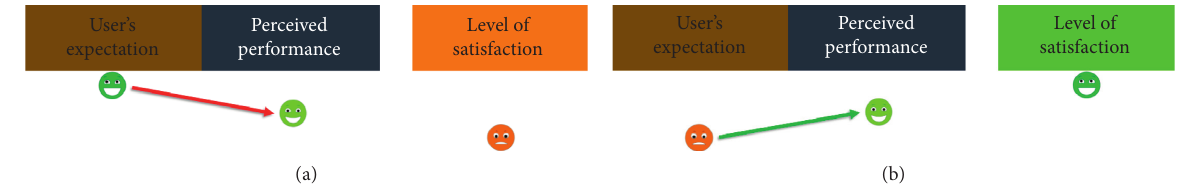
Figure 1: (a) Negative disconfirmation or dissatisfaction and (b) positive disconfirmation or satisfaction in the user’s satisfaction